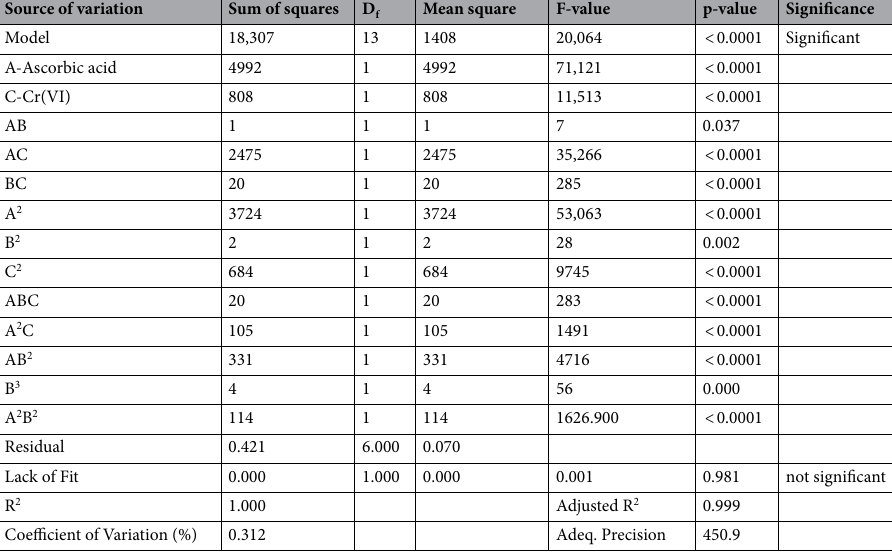
experimental data were used to develop a quadratic empirical model to correlate the factors and one of the responses (Cr(VI) reduction (%)). The RSM model, hence obtained, after elimination of the non-significant model terms through backward elimination, is presented by Eq. (2). Cr ( VI ) reduction ( % ) = 99.79 + 29.71 A − 11.95 C + 0.25 AB + 17.59 AC + 1.58 BC − 17.61 A 2 − 0.41 B 2 Equation (2) can help estimate the Cr(VI) reduction (%) as a function of ascorbic acid (A), humic acid (B), and initial Cr(VI) (C) concentration (mg/L). In the equation, the signs (positive/negative) of the regression coefficients represent the synergistic/antagonistic effect of the parameters on the response. The magnitudes of the coefficients are indicative of their relative impact on the response. It can be inferred from the equation that ascorbic acid (A) imparts the single biggest positive impact on the reduction of Cr(VI) with a coefficient of 29.71 in Eq. (2). While the initial Cr(VI) concentration (C) showed a negative impact on the Cr(VI) reduction (%). However, comparing the magnitude of the two coefficients, it was deduced that the relative impact of initial Cr(VI) concentration is less pronounced than the ascorbic acid dosage 31,36 . The adequacy of the RSM model was statistically verified by performing the analysis of variance (ANOVA). The results of the ANOVA are summarized in Table 3. The statistical significance of the model and its terms were assessed by F-values and p-values. The high F-value along with the p-value below 0.0001 indicates the high statistical significance of the quartic model (i.e., over 99.99% confidence). As shown in Table 3, the p-values of all the terms were below 0.05 indicating their significance above 95% confidence level. The non-significant lack of fit justifies the adequate fitting of the model to the experimental data, thereby guaranteeing further confidence in the developed model 32,37 . The signal to noise ratio can be estimated from adequate precision value which com- pares the range of predicted values at the design points to the average prediction error 27,31 . Adequate precision value of above four is desirable to discriminate signal from noise. The model’s adequate precision value was more than two orders of magnitude higher than the desired value, thereby indicating the overwhelming abundance of signal when compared to noise for the development of the model. Consequently, statistical analyses establish the robustness of the RSM model. The predictability of the RSM model was assessed by plotting model predicted values against experimental Cr(VI) reduction (%), as shown in Fig. 2. The dataset yielded a perfect determination coefficient (R 2 = 1) and a very high adjusted determination coefficient (adj. R 2 = 0.999). This illustrates the high precision of the RSM model to describe the Cr(VI) reduction with respect to ascorbic acid, humic acid, and initial Cr(VI) concentration 31,37 . The contribution of each term towards the final model was calculated by performing the Pareto analysis illus- trated in Fig. 3. The analysis establishes the highest contribution of ascorbic acid on Cr(VI) reduction and initial Cr(VI) concentration is ranked second. Humic acid was found to minimally influence the Cr(VI) reduction 38 . Effect of ascorbic acid, humic acid, and Cr(VI) initial concentration. The effects of the three param- eters on Cr(VI) reduction were studied with the RSM plotting one-factor plots and three-dimensional (3D) sur- face plots. Figure 4 shows the one-factor plots to observe the individual effects of ascorbic acid (A), humic acid (B), and initial Cr(VI) (C) concentration on the reduction of Cr(VI) in the studied systems. The one-factor plots